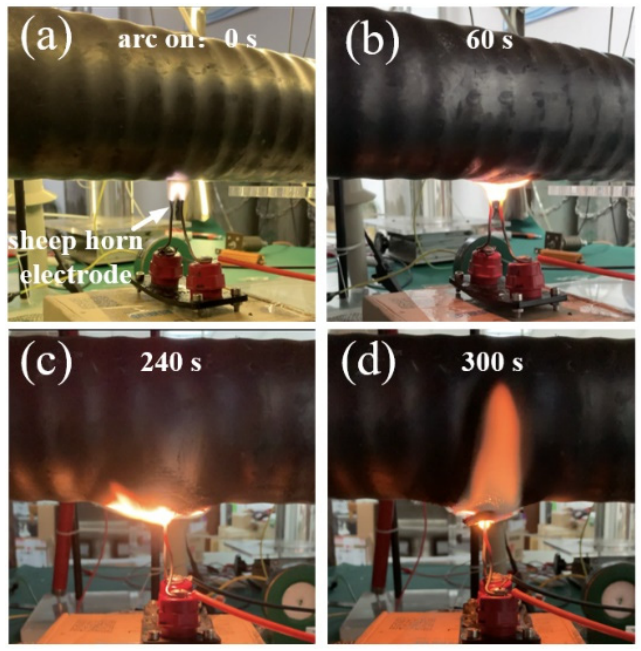
Figure 5. The ignition of the cable fire.